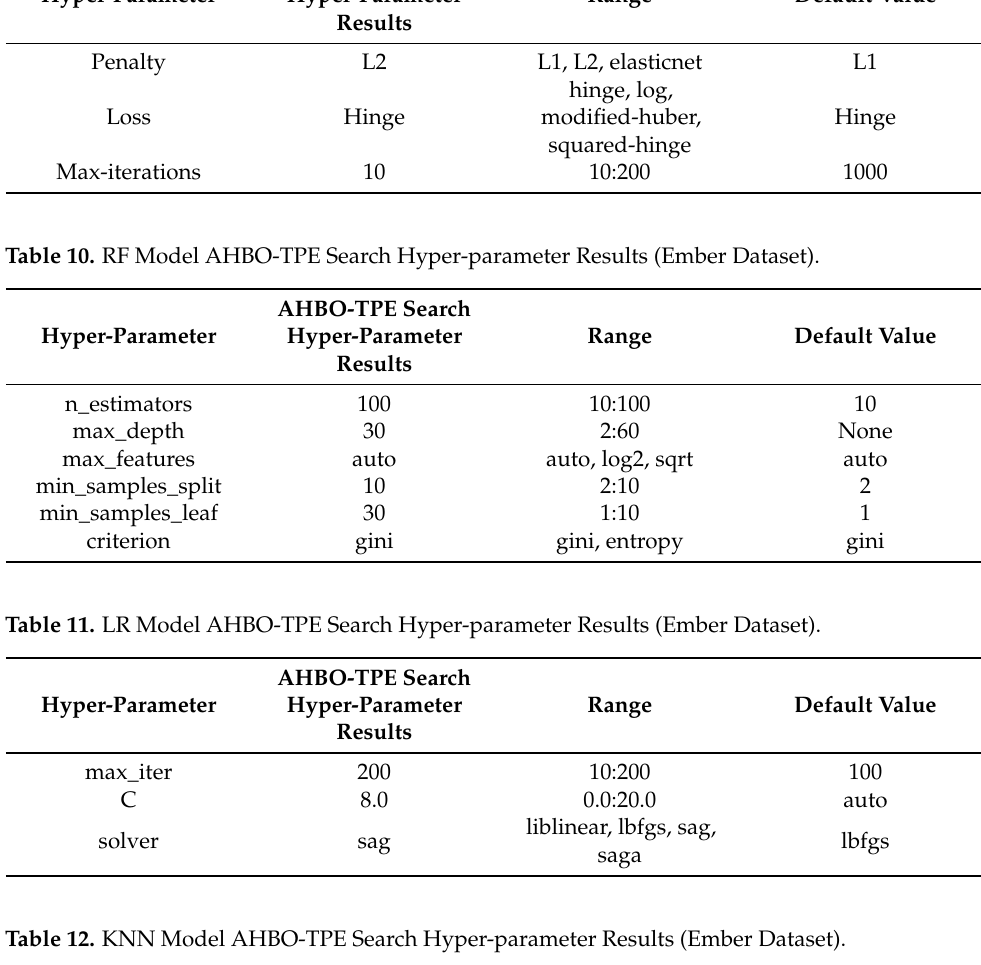
Hyper-Parameter